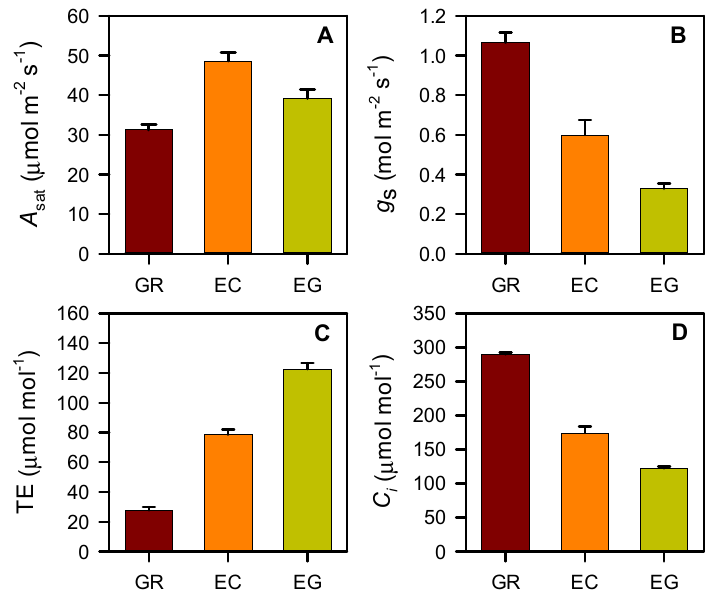
); (B) stomatal conductance (gs); sat concentration ( C ) of 2 i